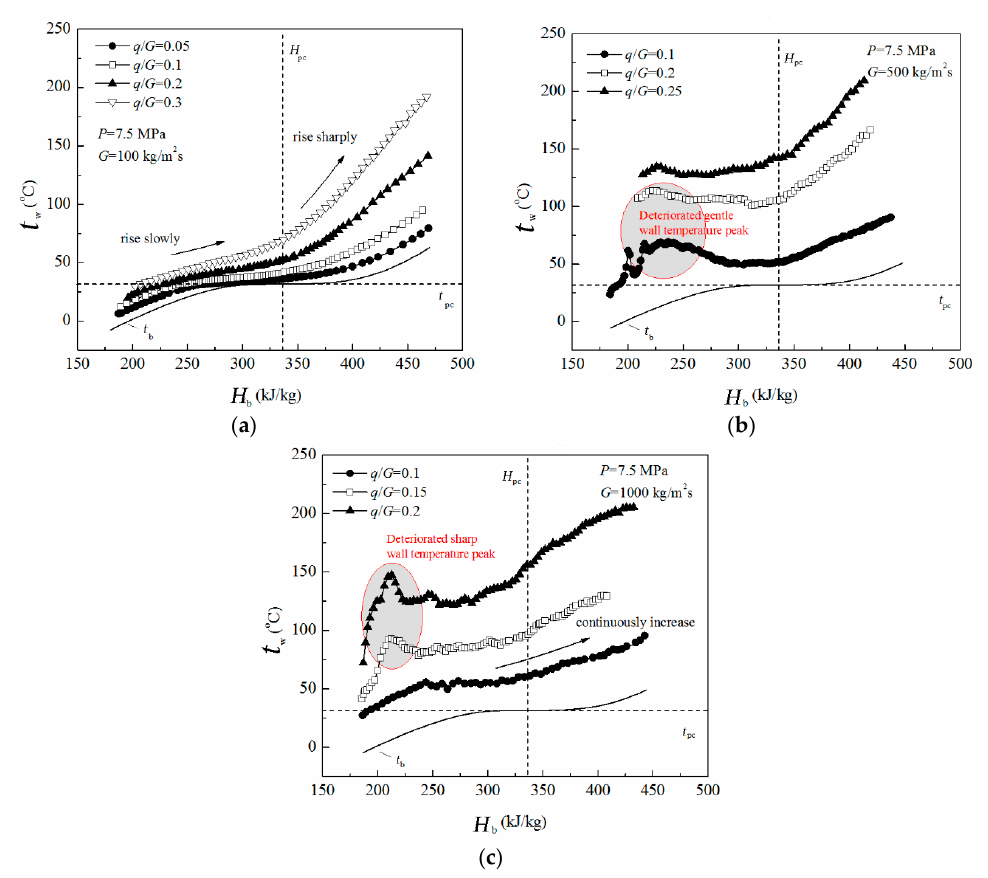
Figure 3. Experimental profiles of the inner-wall temperatures for different mass fluxes. ( a ) G = 100 kg/m 2 s; ( b ) G = 500 kg/m 2 s; ( c ) G = 1000 kg/m 2 s.